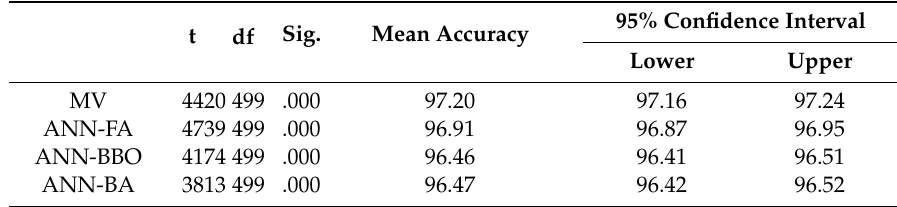
Table 14. Statistical di ff erences between accuracy of majority voting (MV) and other method in 500 iterations.